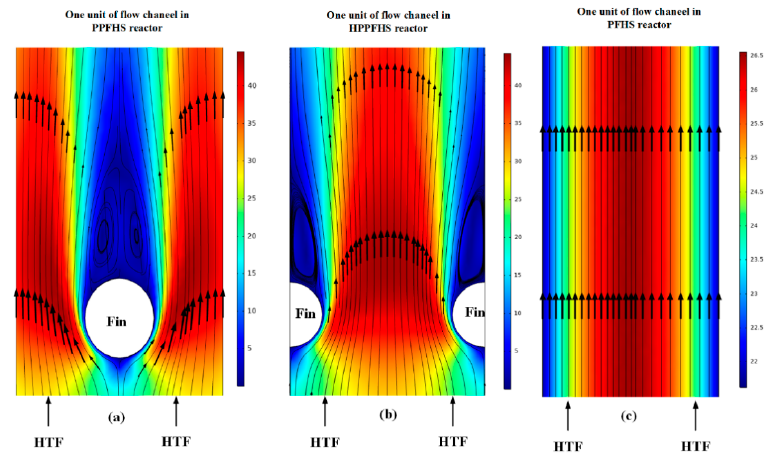
Figure 8. Streamline profile in the channel at 300 min (dehydration, ε = 0.5, u = 25 m/s). ( a ) PPFHS reactor. ( b ) HPPFHS reactor. ( c ) PFHS reactor.